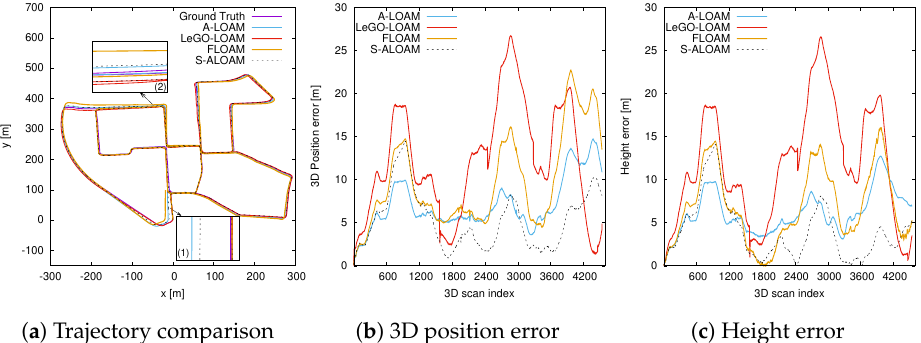
Figure 6. The trajectory comparison in Sequence 00. ( a ) The plot of the trajectories from different methods. ( b ) The absolute 3D translation error. ( c ) The absolute height error. Rectangles in ( a ) are enlargements of the corresponding